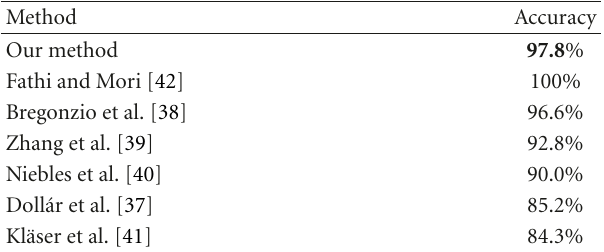
Table 4: Comparison with other recent methods on Weizmann